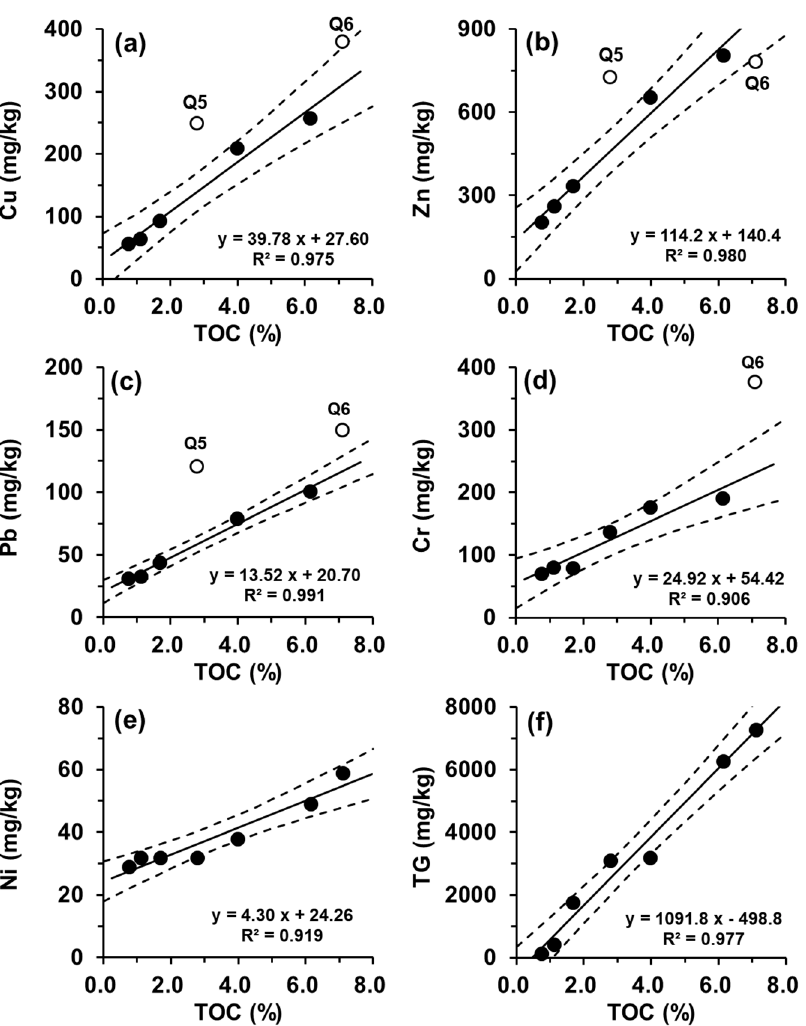
Figure 4. Relationships of ( a ) Cu, ( b ) Zn, ( c ) Pb, ( d ) Cr, ( e ) Ni, and ( f ) total grease (TG) with total organic carbon (TOC) contents in the sediments of Qianzhen Fishing Port. The dashed lines represent confidence interval at the 95% confidence level. The hollow circles denote the outliers. Table 4. Comparison among the average contents (mg/kg) and normalized ratios of heavy metals in the sediments of Qianzhen Fishing Port and other regions